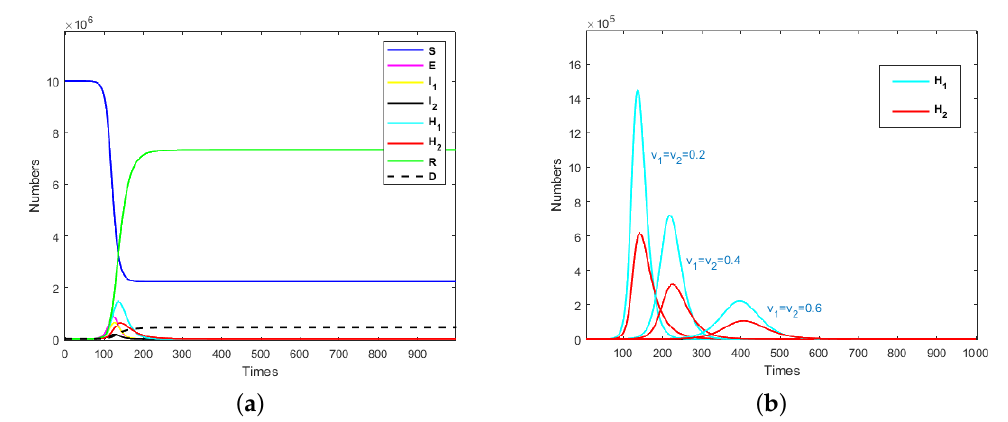
Figure 2. ( a ) Evolution results of the population when v 1 = v 2 = 0.2 and M = 10 7 ; ( b ) evolution results of isolated mildly and severely infected individuals when v 1 = v 2 = ( 0.2,0.4,0.6 ) .